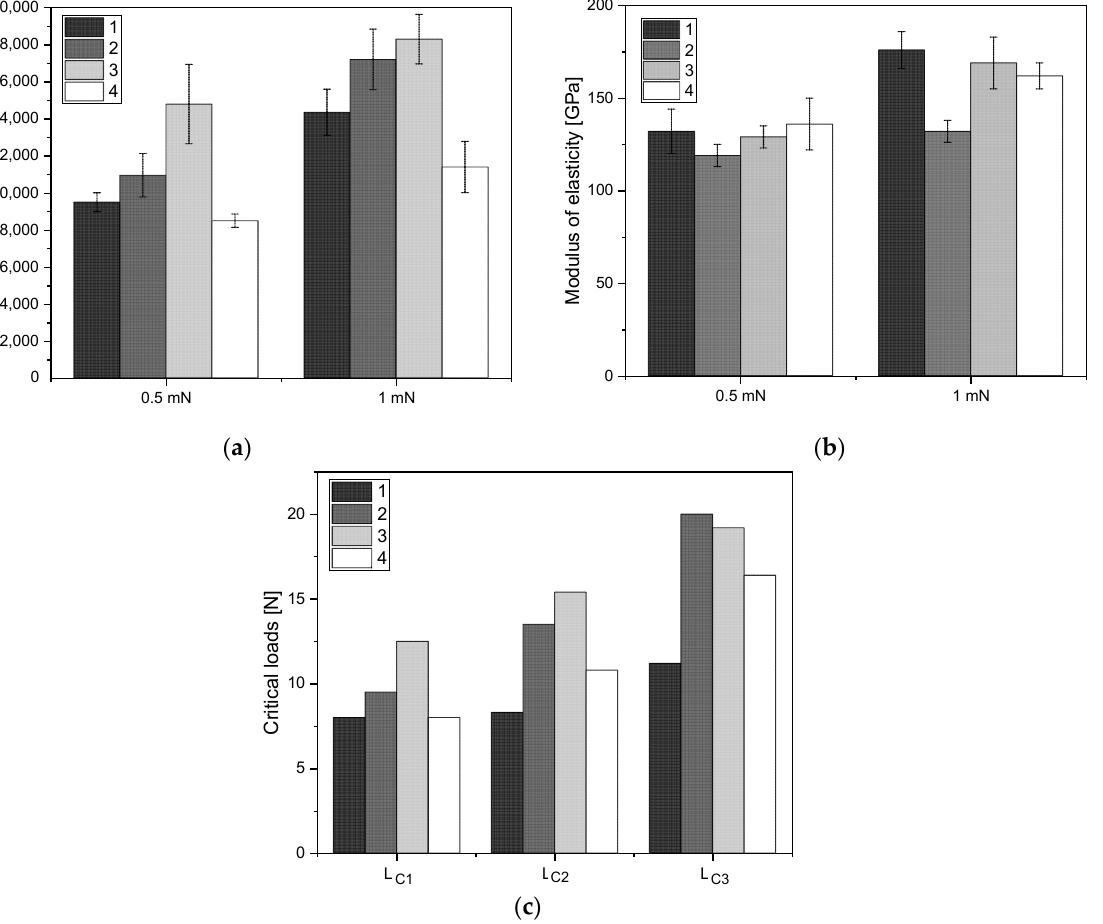
Figure 6. ( a ) Hardness values for 0.5 mN and 1mN; ( b ) Modulus of elasticity for 0.5 mN and 1 mN;